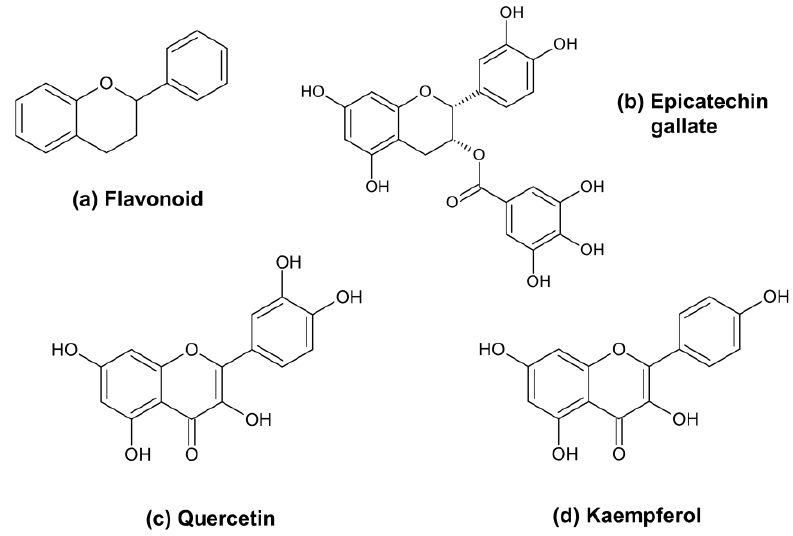
Figure 1. The basic skeleton of flavonoids ( a ) and structures of major flavonoids in Orostachys : epicatechin gallate ( b ), quercetin ( c ), and kaempferol ( d ).